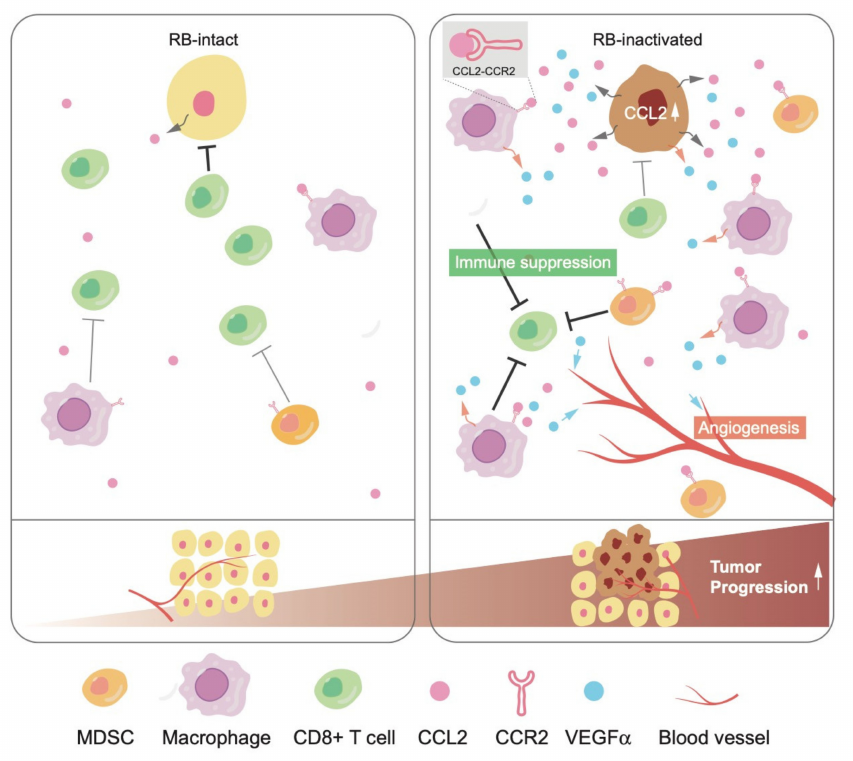
Figure 2. RB impacts the TME via cytokine and chemokine secretion. RB inactivation upregulates CCL2 and VEGF α secretion, which recruits immune suppressive cells, such as MDSCs and tumor-associated macrophages and promotes angiogenesis.